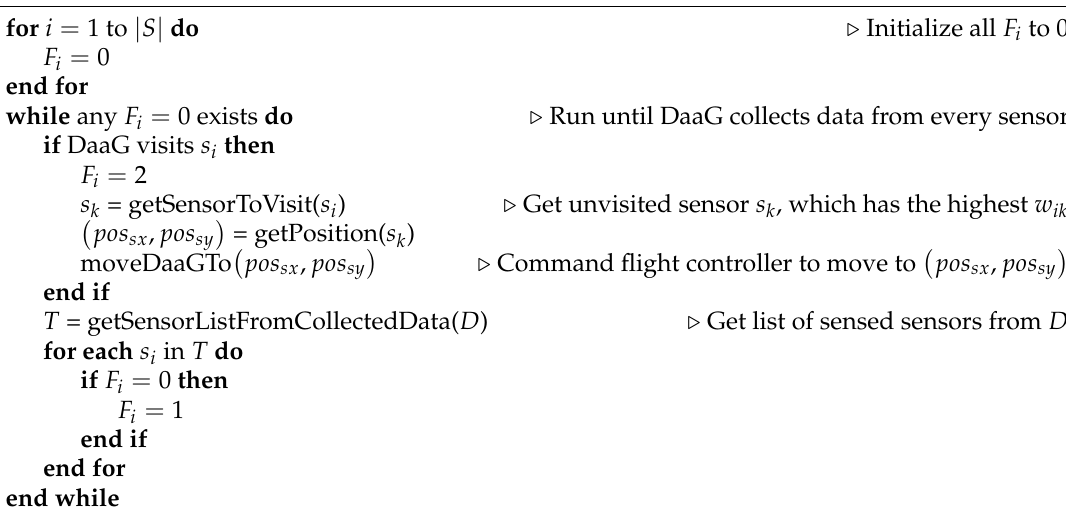
Algorithm 2 Path-planning algorithm in the sensor network.